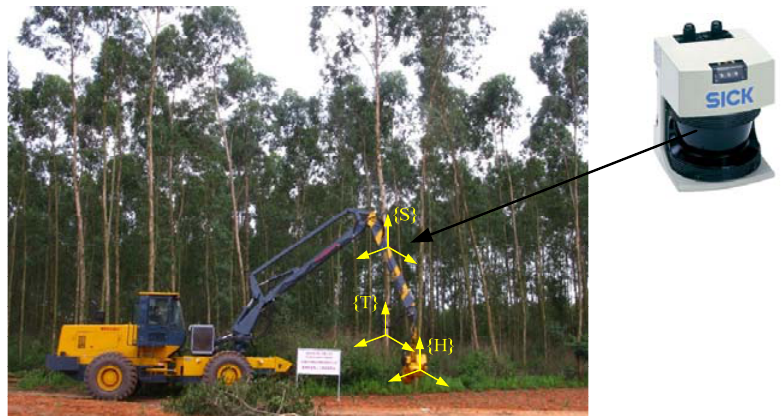
Figure 7. Implement on the logging